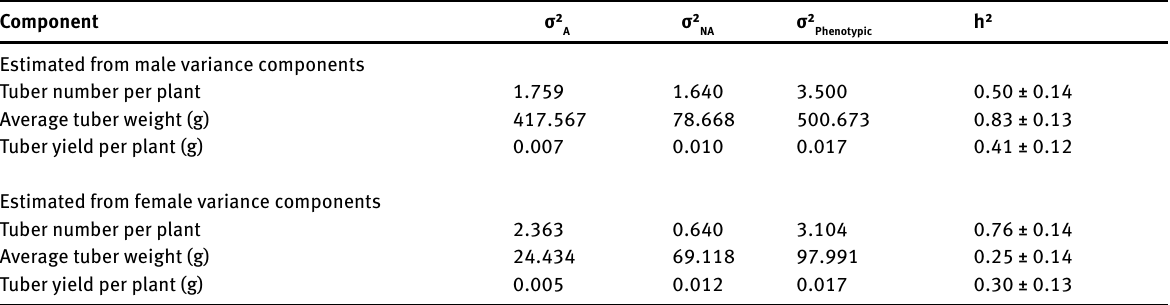
Table 6: Estimates of additive and non-additive genetic variance, and Narrow-sense heritability, estimated from male and female variance